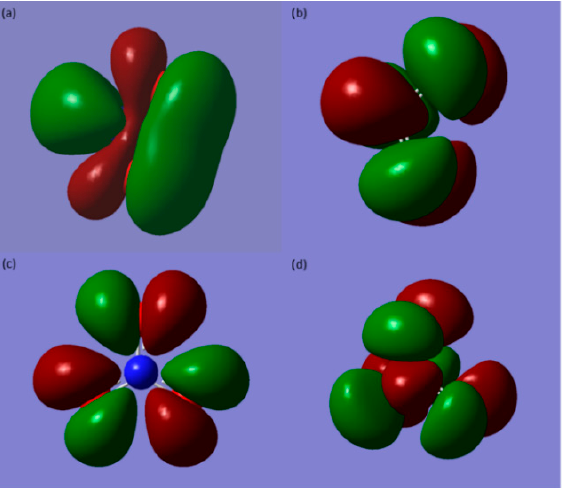
Figure 11. The distribution of electron density for ( a ) NO 2 − HOMO, ( b ) NO 2 − LUMO, ( c ) NO 3 − HOMO, and ( d ) NO 3 − LUMO using DFT/B3LYP/6-31G (d, p).